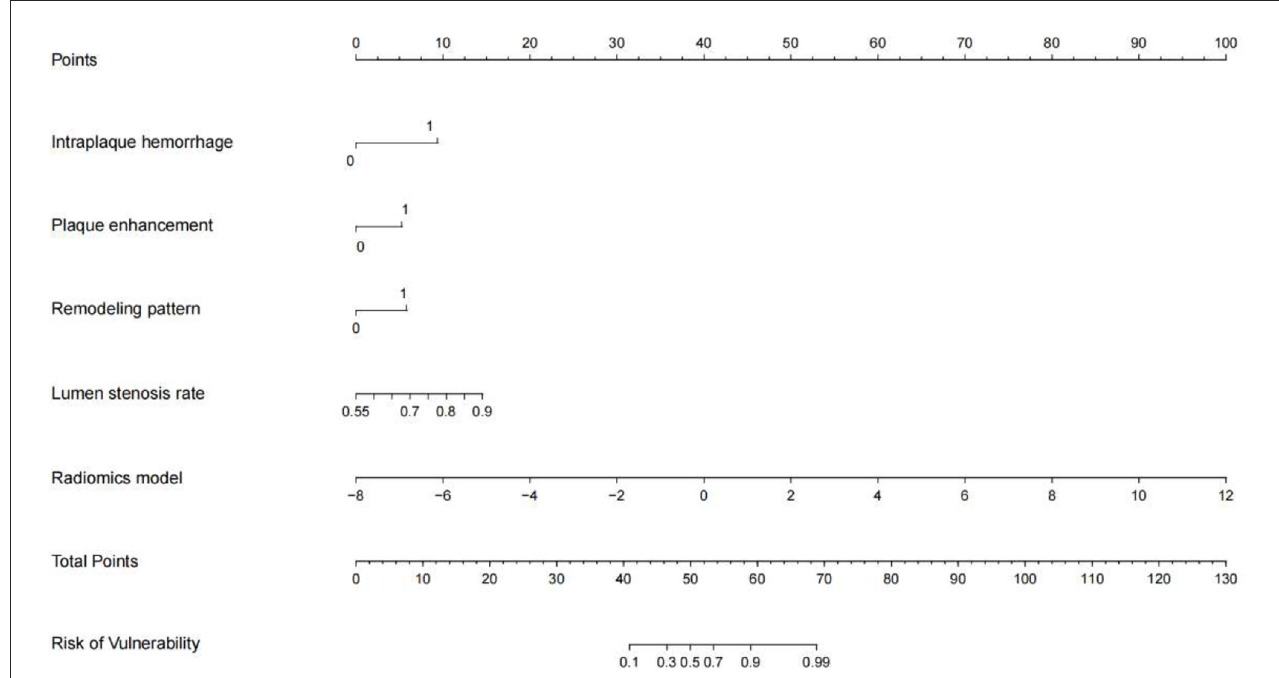
FIGURE3 A nomogram integrating the radiomics scores and traditional features of the training